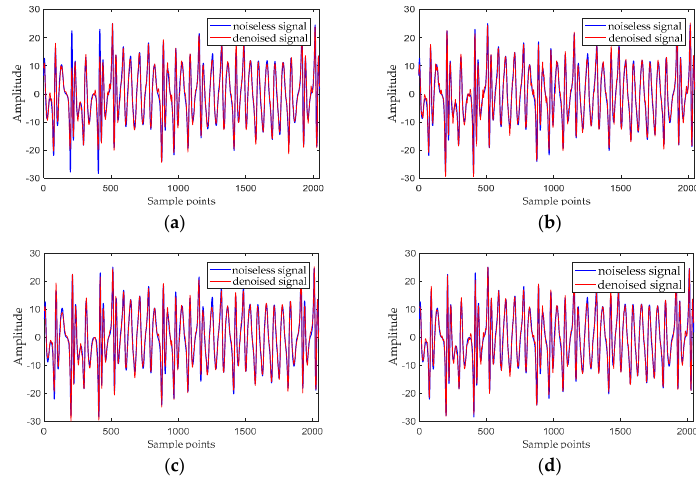
Figure 9. Time-domain waveforms for ( a ) the EMD-DE-IT method; ( b ) the EEMD-DE-IT method; ( c ) the CEEMD-DE-IT method; and ( d ) the proposed method.